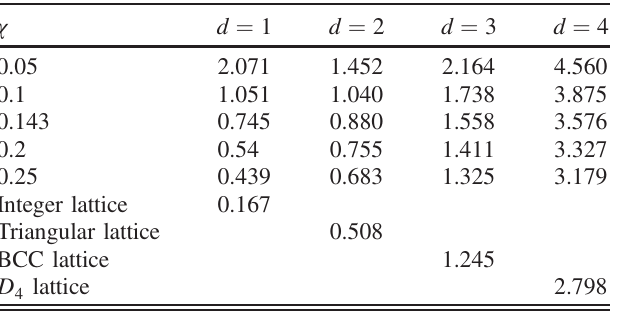
¯ B TABLE V. The order metric for various values of χ across the first four dimensions for disordered stealthy ground states for selected values of χ up to χ ¼ 0 . 25 , as obtained from the analytical estimates of σ 2 ð R Þ and Eq. (87). Included for com- parison are the structures in each dimension that have the minimal ¯ B values of , all of which are Bravais lattices [31,32].